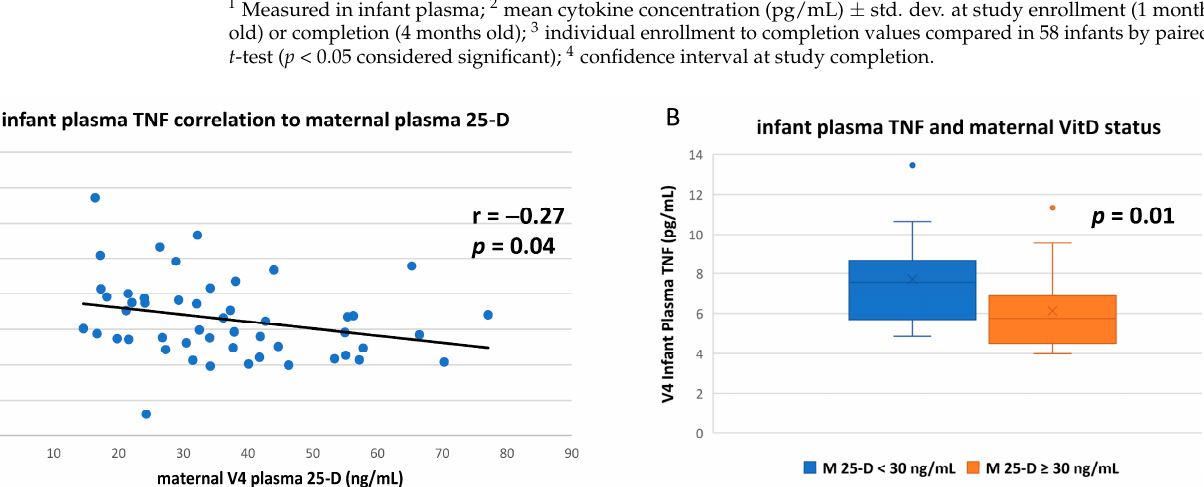
Table 2. Changes in infant plasma cytokine concentrations from study enrollment to completion.